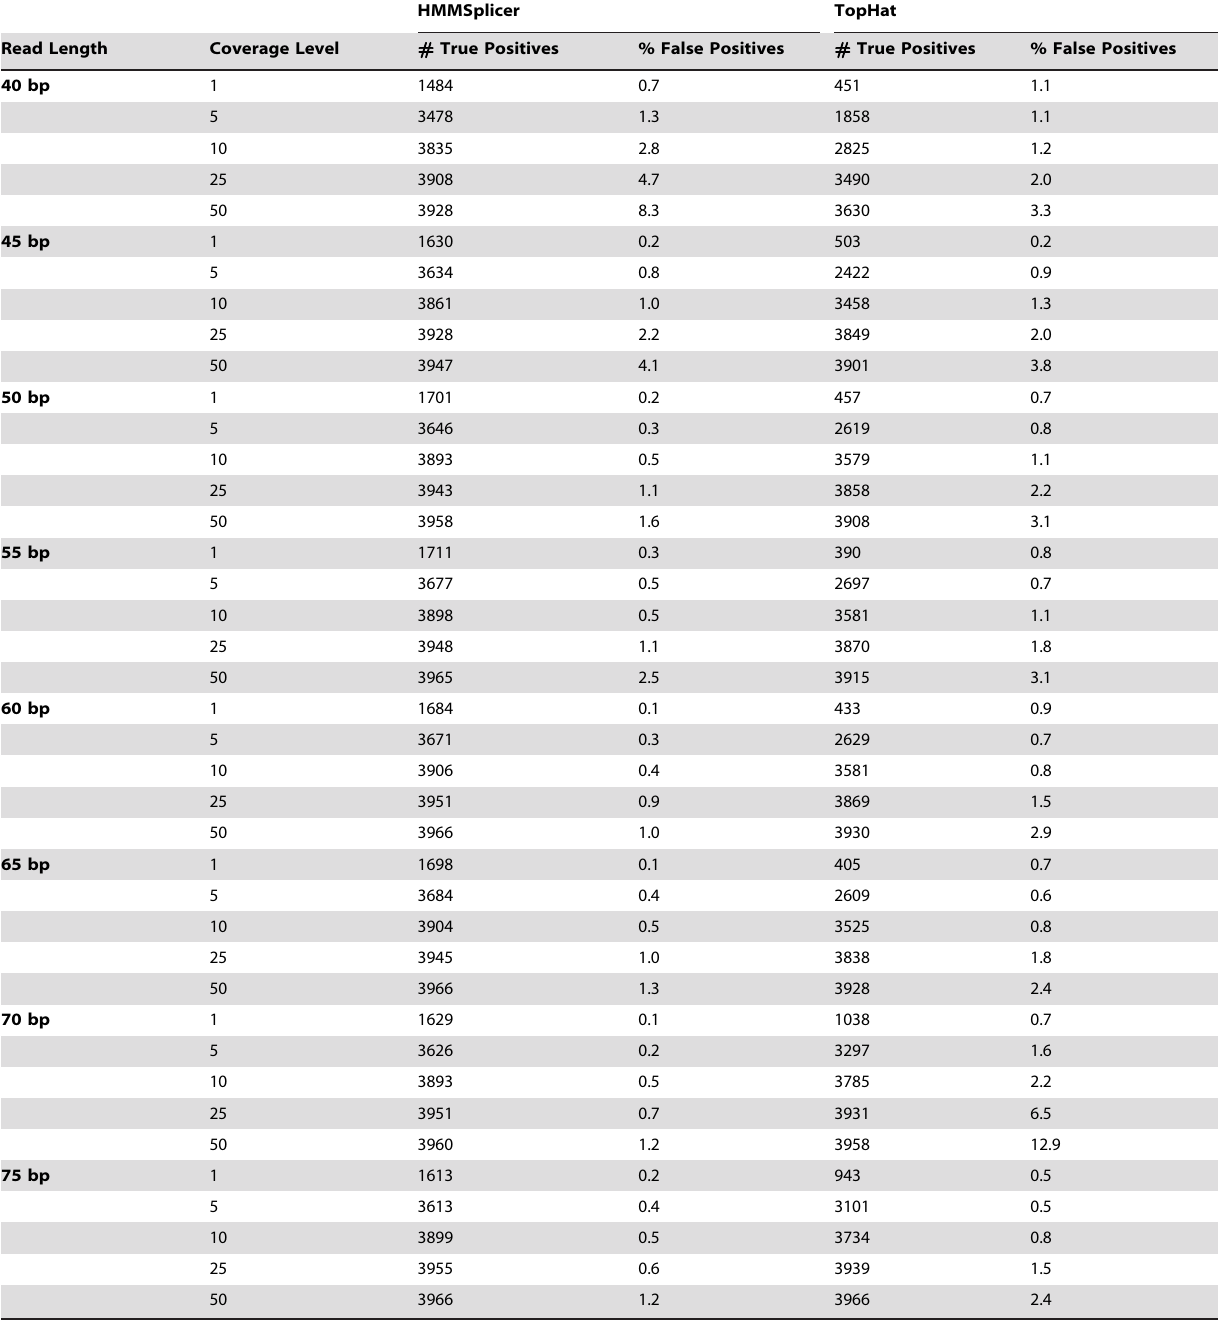
Table 2. Simulation Results.